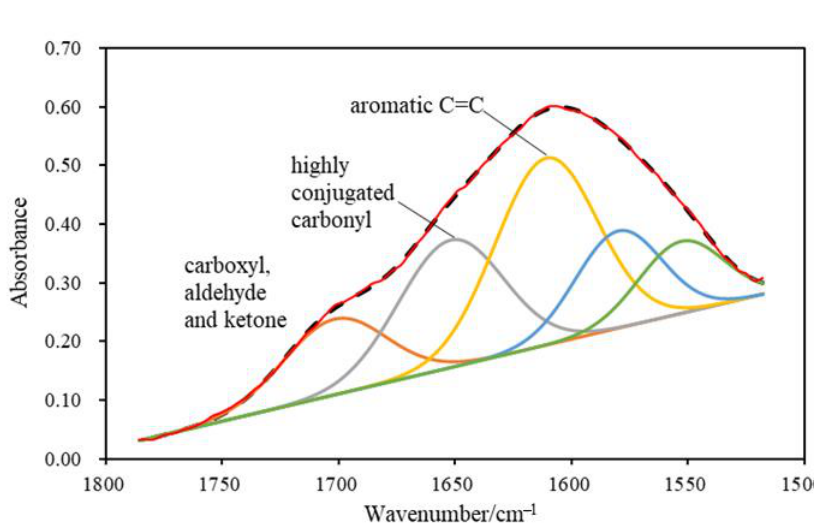
Figure 3. Schematic showing the peak resolving of the ~1500–1800 cm −1 FTIR region. Solid envelopes represent measurements, whereas the dashed envelope indicates a summary curve.